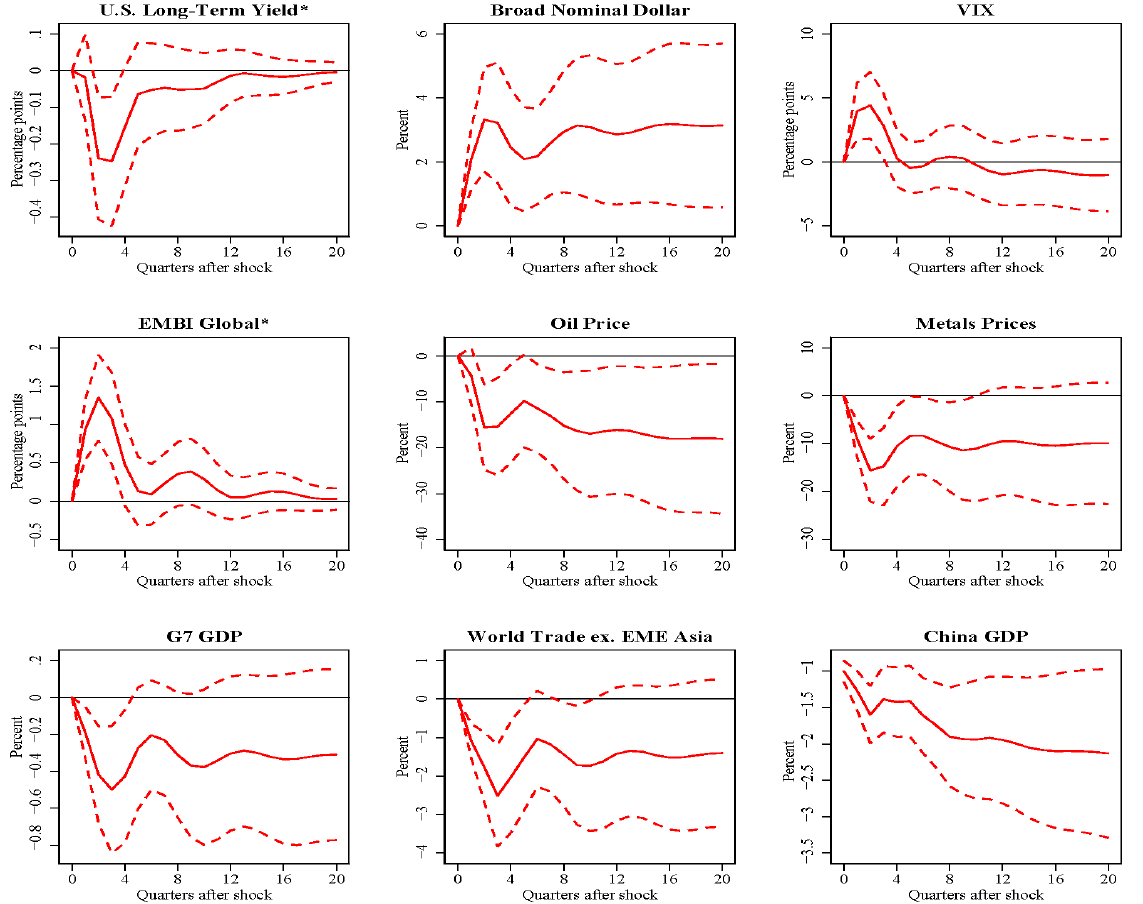
Figure 5. Responses to a negative unit domestic China GDP Shock. * Noncumulative response. Note: the dashed lines represent the upper and lower bounds of the 90% confidence interval around the impulse response estimate. Source: authors’ calculations using data from Haver Analytics and Bloomberg.